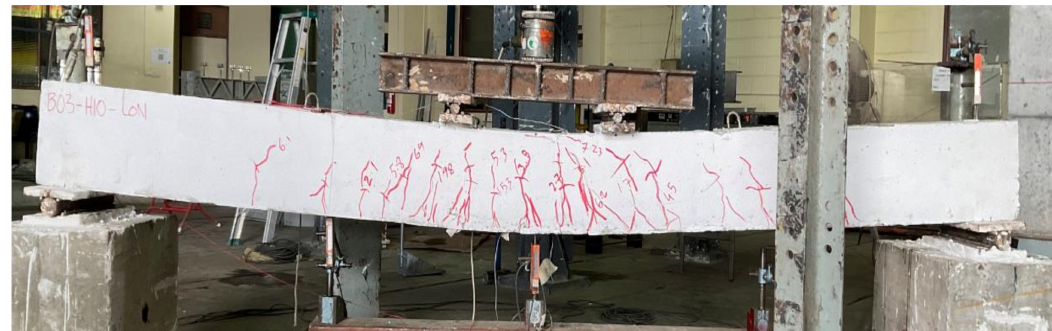
Figure 11. Failure mode of beam